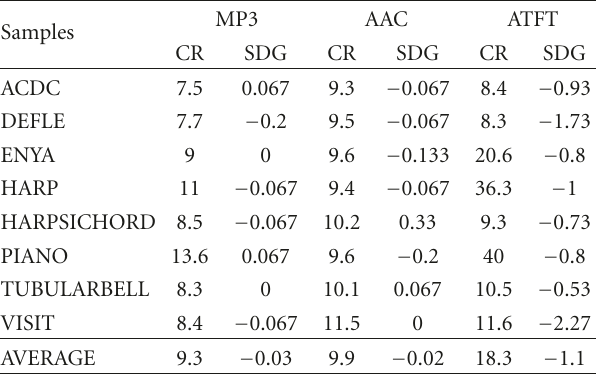
Table 1: Compression ratio (CR) and subjective di ff erence